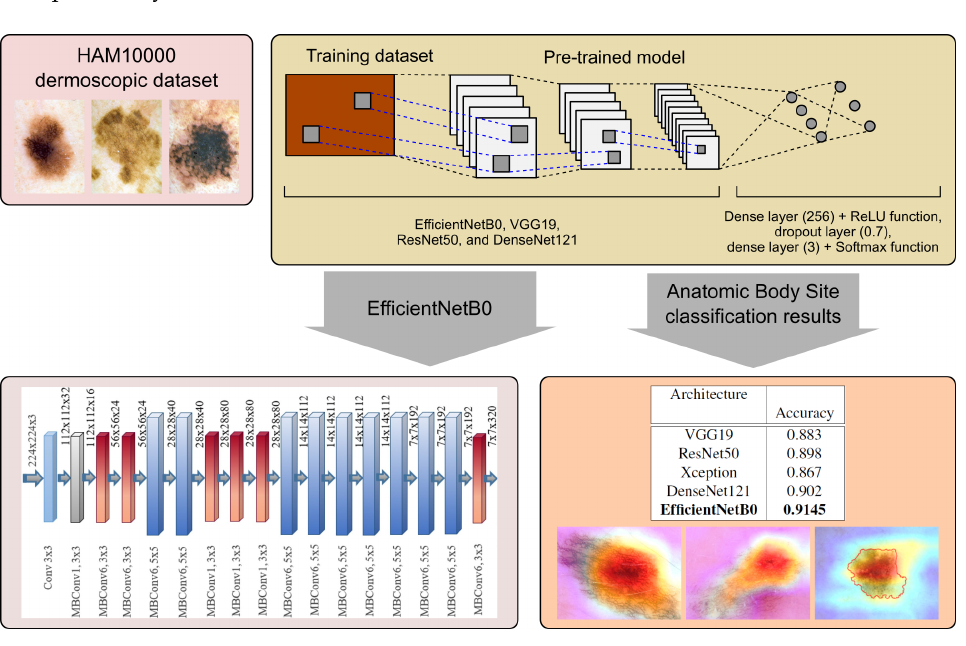
Figure 4. The streamline of our proposed framework. We use pretrained deep learning models in- cluding VGG19, ResNet50, DenseNet121, and EfficientNetB0 for feature extraction on the HAM10000 dataset. We employ the extracted features to conduct the multi-class classification task. Finally, we perform model evaluation and interpretation based on the